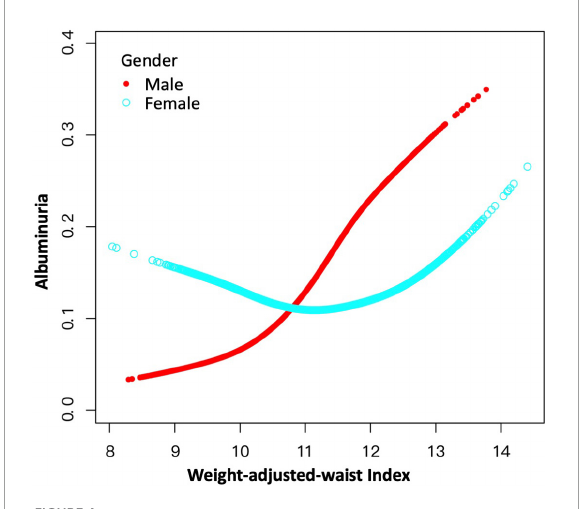
FIGURE4 A non-linear positive relationship between WWI and albuminuria in females by the generalized additive model. Non-linear positive relationships were detected in females with a breakpoint of 10.92. WWI positively associated with the likelihood of albuminuria on the right side of the breakpoint, while the association on the left of the breakpoint was of no statistical significance.